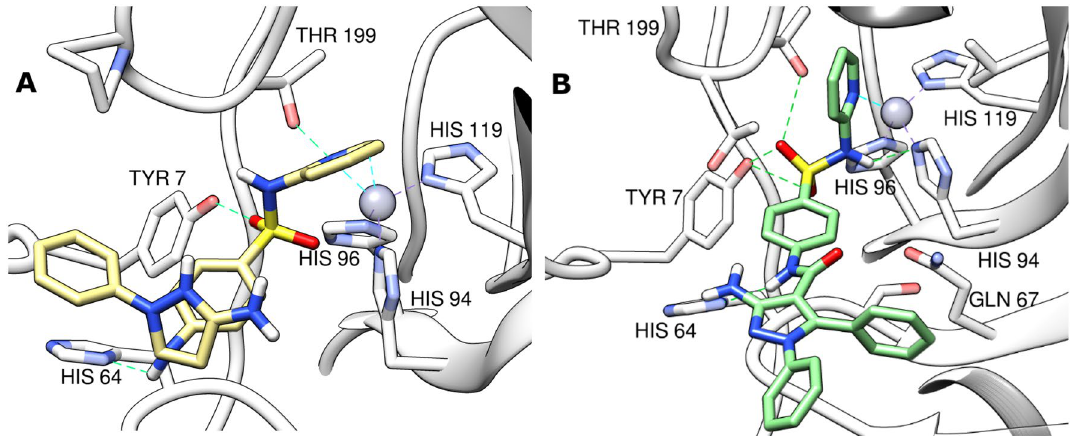
Figure 11. 3D interaction diagrams for CA IX (PDB ID: 7pom) (grey) with compound 3 (khaki) ( A ) and compound 11 (green) ( B ). Grey dashed lines: coordination of histidine triad with zinc, cyan dashed lines: coordination of compounds with zinc, green dashed lines: conventional hydrogen bonds.